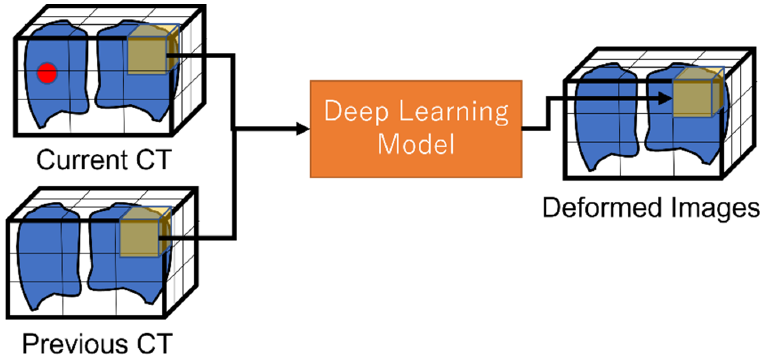
Figure 3. Schematic of deep neural network registration for each patch.